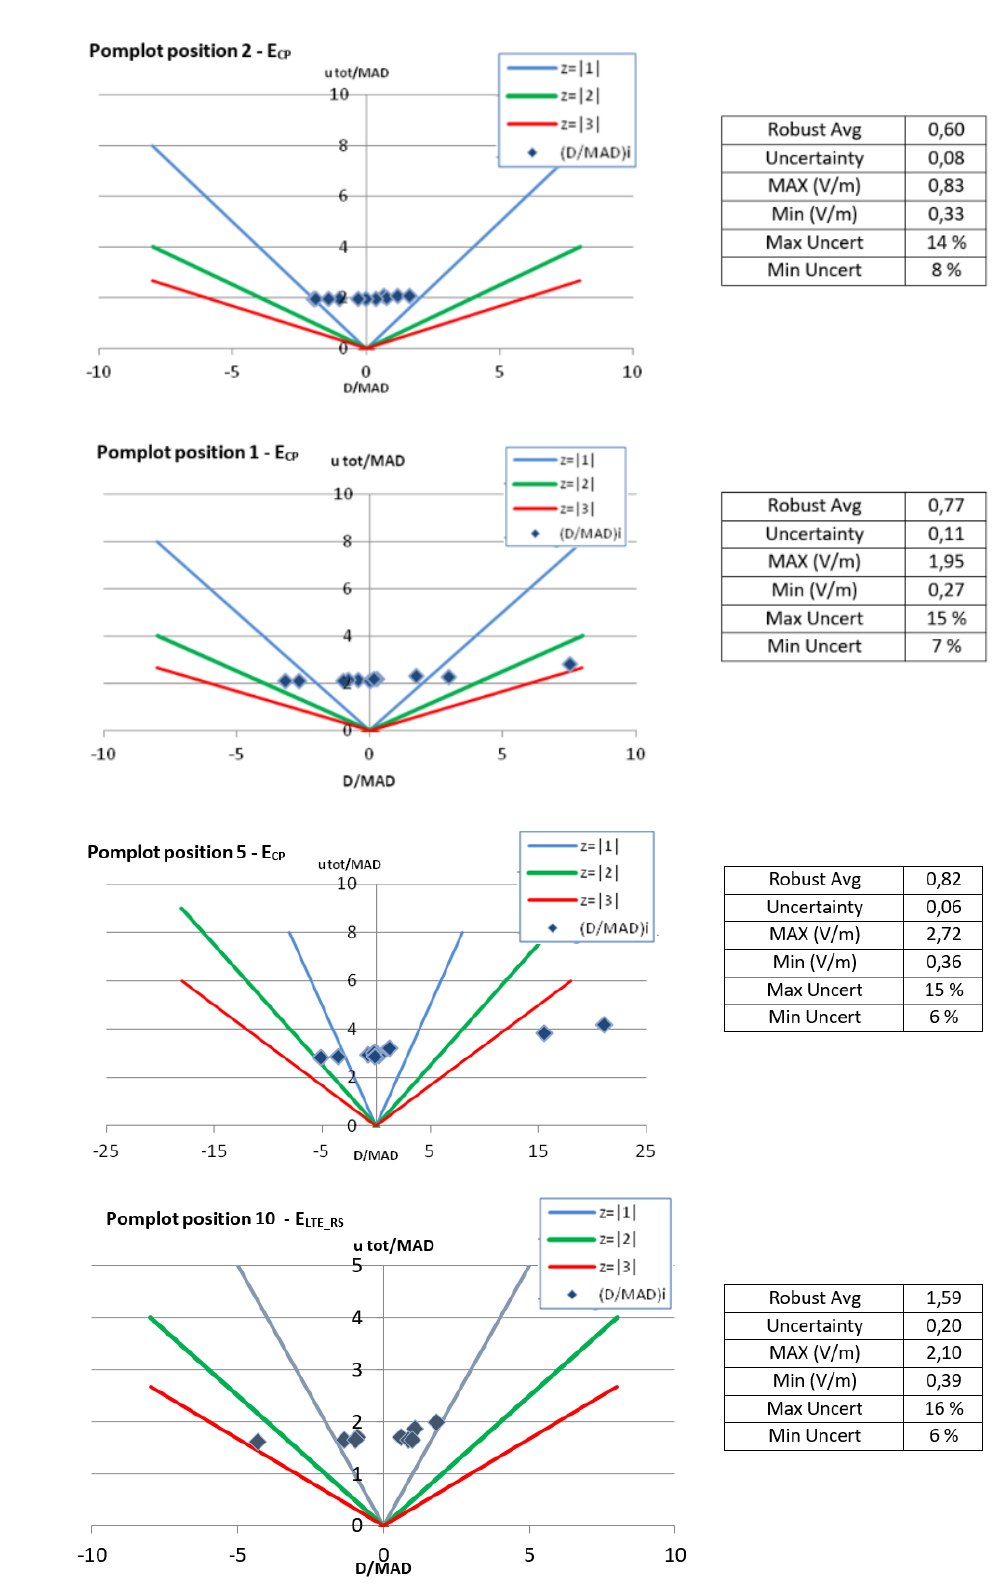
Figure 6. Graphical representation (PompPlots) of the results obtained in some positions: ( a ) E CP in position 2, ( b ) E CP in position 1, ( c ) E CP in position 5, ( d ) E LTE_RS in position